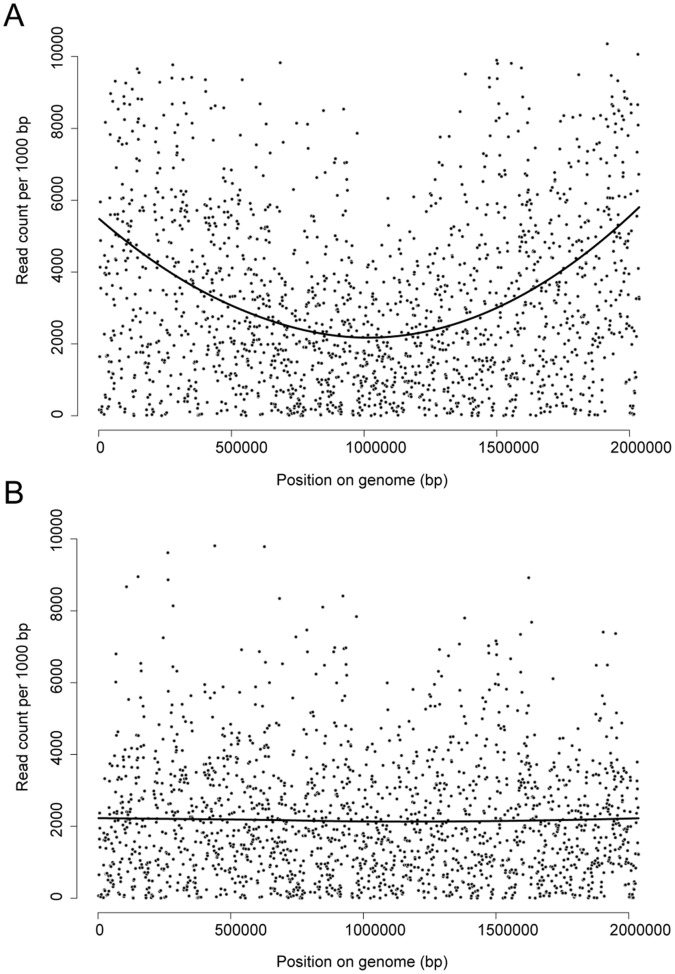
Read count as a function of genomic position per 1 kb.Read count of a single Tn-seq experiment of S. pneumoniae R6 gene essentiality as a function of the genomic position before (A) and after (B) genomic location correction using Loess. Each dot represents 1 kb of sequence. Regression on the data was performed using Loess as implemented in the loess R package and plotted on the graph as a black line.